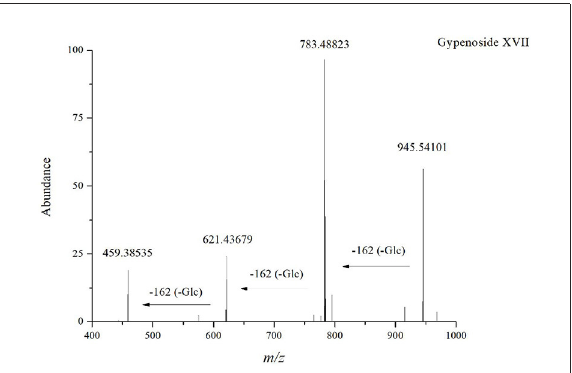
FIGURE2 Tandem mass spectrum of ginsenosides in the negative ion mode: Gypenoside